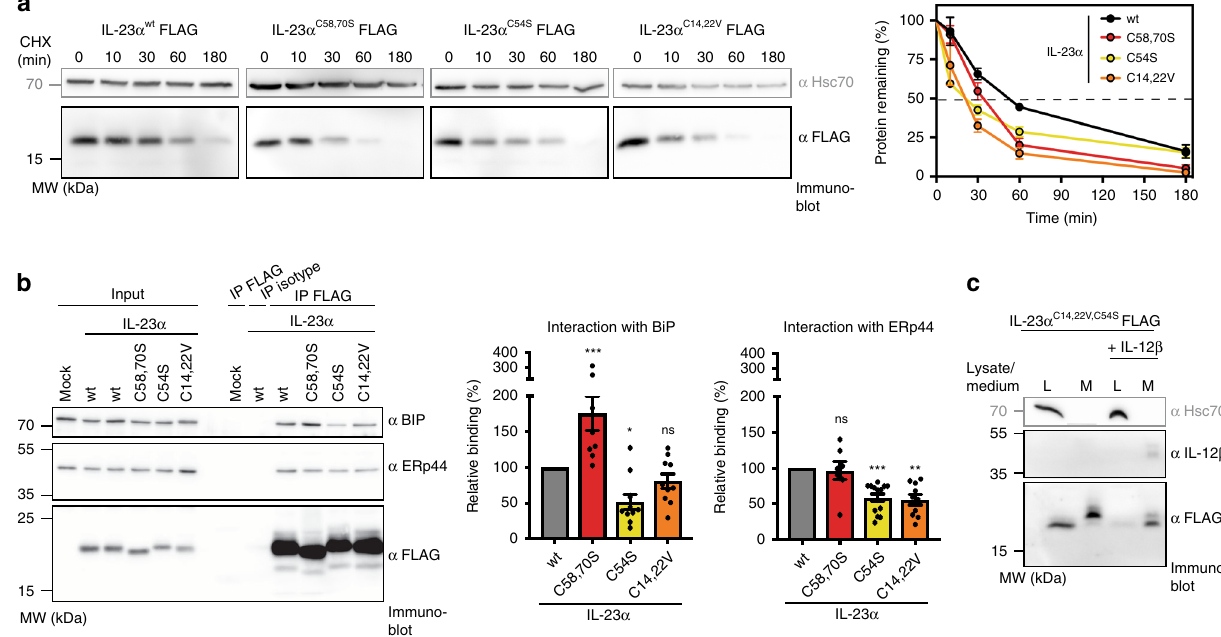
Fig. 2 Cysteines in IL-23 α are recognized by ER chaperones and in fl uence its half-life. a Time course of degradation for IL-23 α wt , IL-23 α C58,70S , IL-23 α C54S , and IL-23 α C14,22V upon inhibition of translation with cycloheximide (CHX) for up to 180min. Hsc70 served as loading control. Right: Quanti fi cation of protein turnover is shown; data are the mean ±SEM of at least four independent experiments. Source data are provided as a Source Data File. b Immunoblot analysis of co-immunoprecipitated co-transfected hamster BiP or endogenous ERp44 with FLAG-tagged IL-23 α wt , IL-23 α C58,70S , IL-23 α C54S , and IL- 23 α C14,22V . Center and right: Relative binding was determined from at least seven independent experiments (shown ±SEM) and normalized to the IL-23 α wt signal, which was set to 100% relative binding. Statistical signi fi cance was calculated using a two-tailed unpaired t -test. ns = not signi fi cant; * p < 0.05, ** p < 0.01, *** p < 0.001 indicate statistically signi fi cant differences. The IL-23 α C58,70S construct has a shorter linker between the protein and tag, which explains its slightly faster migration. c Secretion behavior of FLAG-tagged IL-23 α C14,22V,C54S in the presence or absence of IL-12 β . Hsc70 served as loading